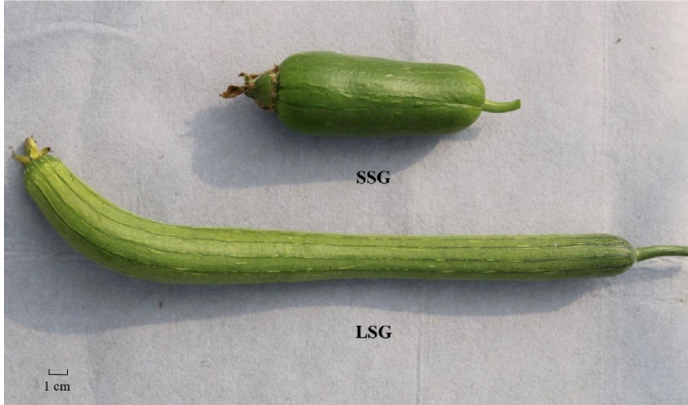
Figure 1. The two materials of sponge gourd used in this